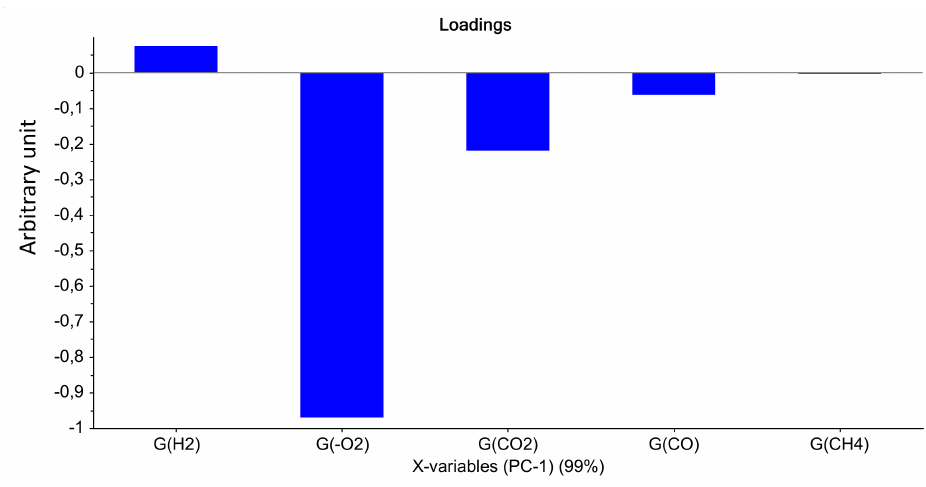
Figure 4. PCA loading for PC1 (Mod 2).